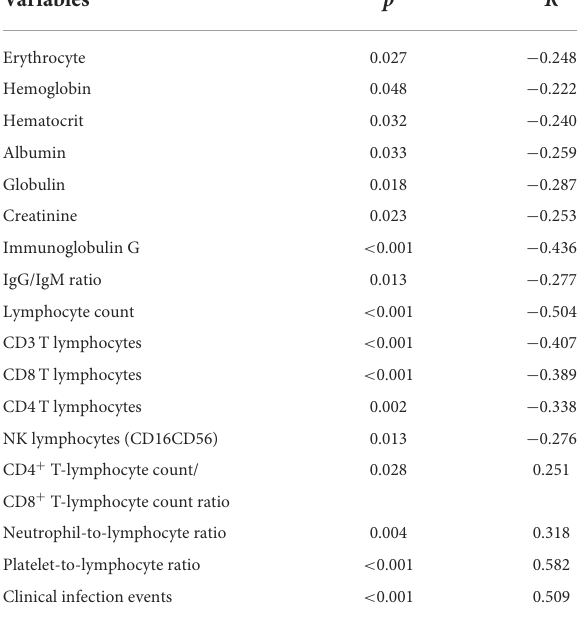
TABLE 4 Point-biserial correlation